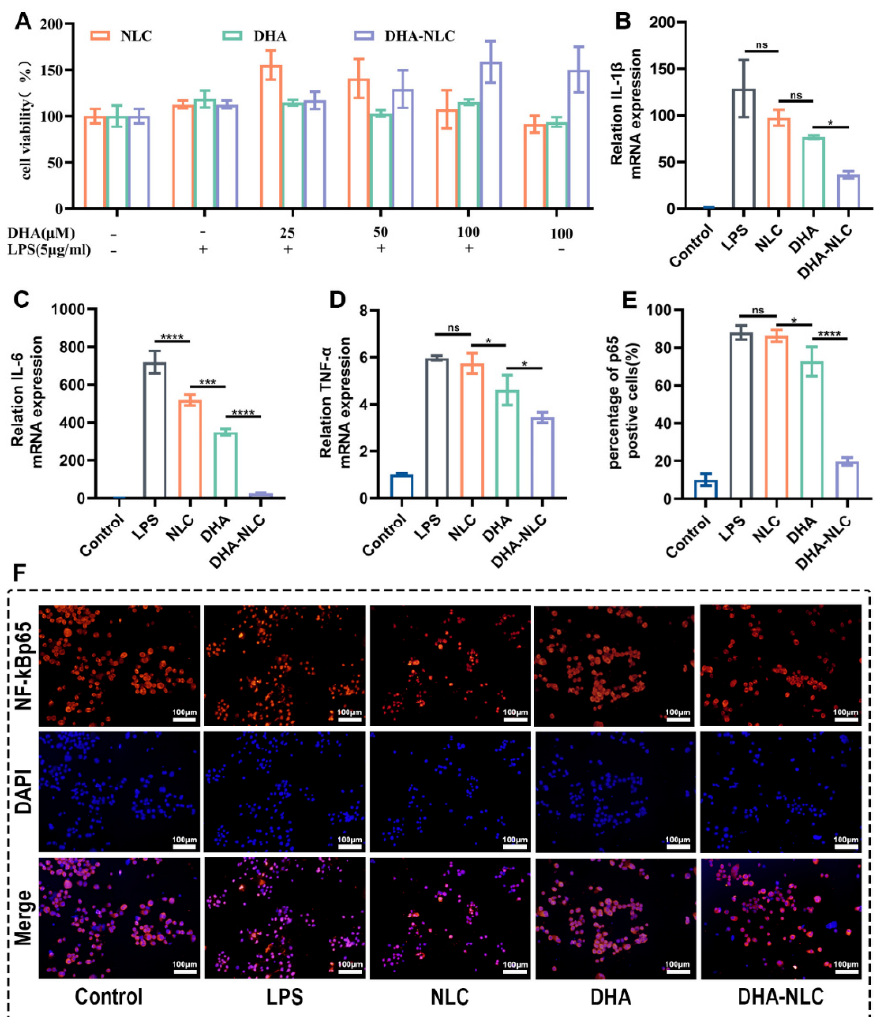
Figure 3. Cytotoxicity and anti-inflammatory effects of each group in vitro. ( A ) Viability of RAW 264.7 cells cultured with NLC, DHA, and DHA-NLC at different concentrations. ( B – D ) Effects of each group on the mRNA expression of IL-1 β , IL-6, and TNF- α in macrophages in vitro (n = 3). ( E , F ) NF- κ B p65 translocation in macrophages was detected by immunofluorescence, and positive cells were counted (n = 3). * p < 0.05, *** p < 0.001, **** p < 0.0001. ns: no statistical significance. Scale bars: 100 µ m. LPS, lipopolysaccharide. NLC, nanostructured lipid carrier. DHA, docosahexaenoic acid.